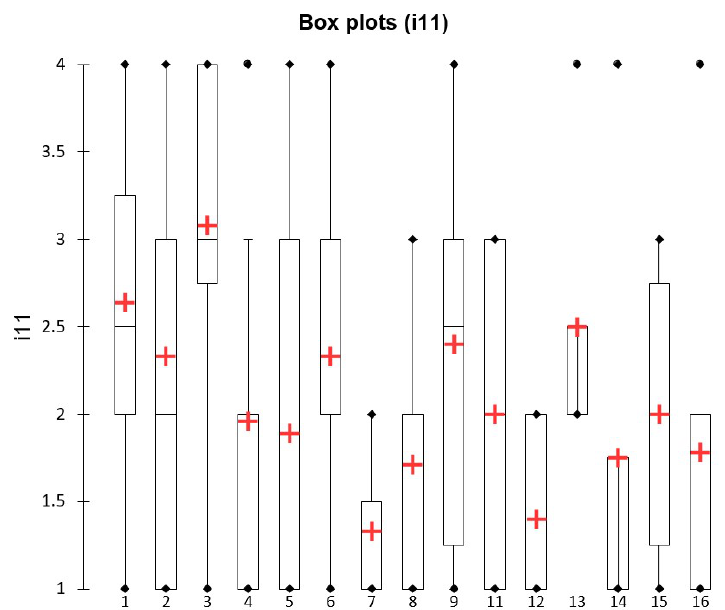
Figure 11. Box plots of the average scores of Item 11 (presentation of contents addressed) according to the typology of the program.